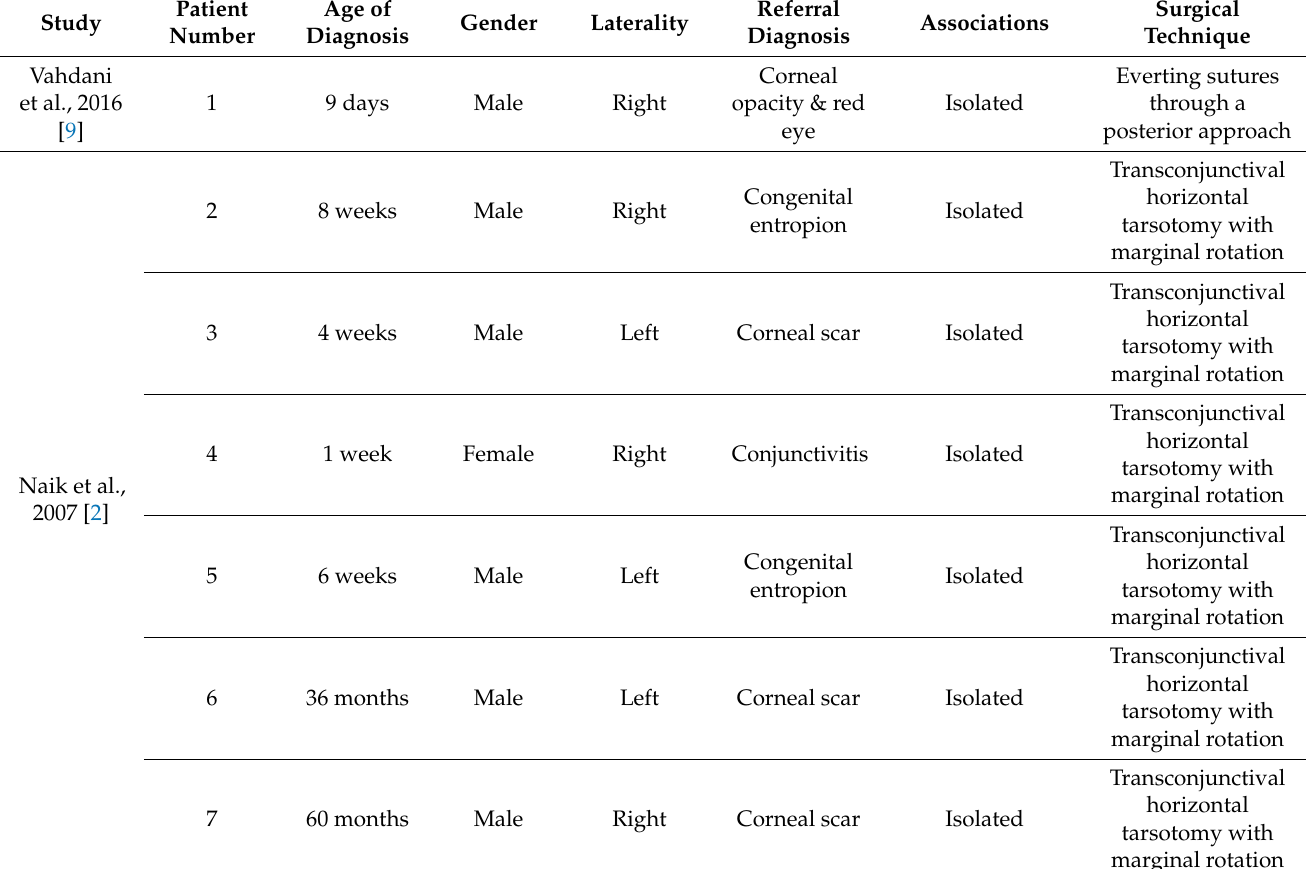
Table 1. Characteristics of congenital tarsal kink syndrome reported